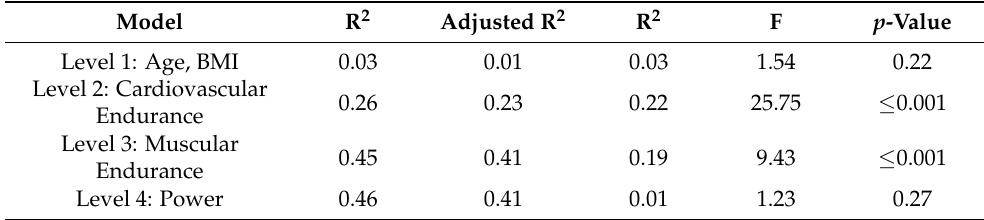
Table 9. Week 1 Hierarchal Regression.